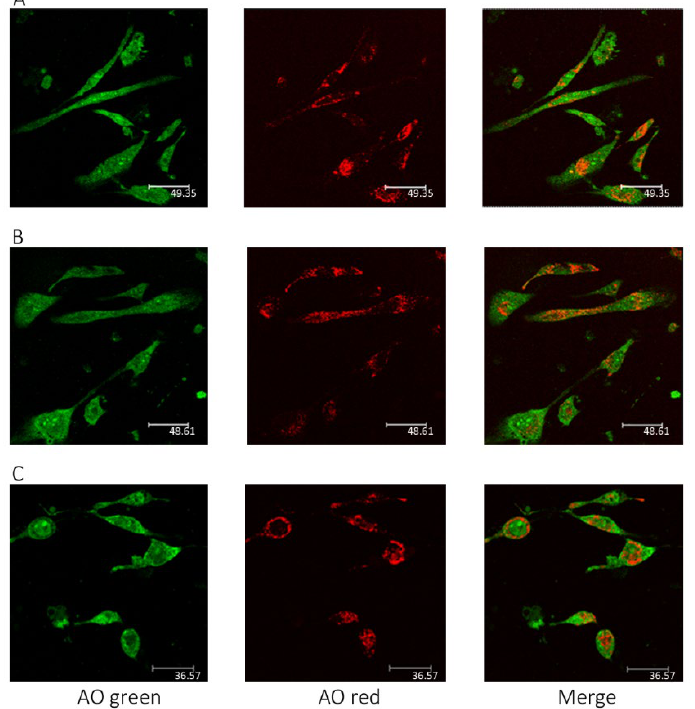
Figure 7. CLSM images of hFOB 1.19 cells labelled with the metachromatic fluorophore AO. ( A ) Control cells; ( B ) osteoblastic cells grown in the presence of CS hydrogel; ( C ) osteoblastic cells grown in presence of CS hydrogel with 1.5 wt% of POSS. In acidic compartment of cytosol (intact lysosomes and mature endosomes; i.e., phagolysosomes), the fluorophore is sequestered thanks to the proton pump and emits a red fluorescence, while it emits green florescence in the absence of a low pH. The cells are morphologically analogous in ( A – C ).